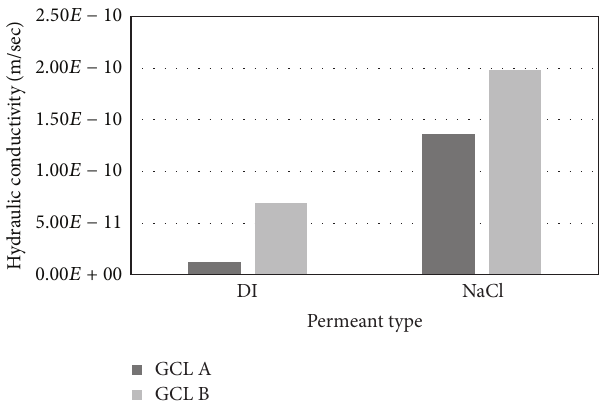
Figure 6: Hydraulic conductivity of the GCL samples after hydra- tion with both distilled water (A-A, B-A) and NaCl (A-S,